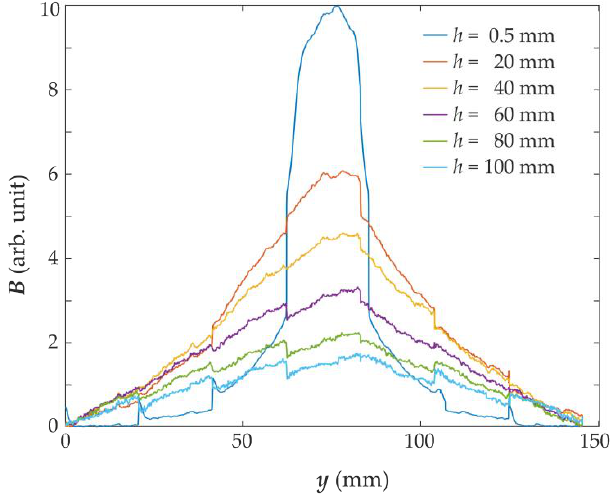
Figure 14. Impact of concrete cover thickness on the MO-sensor measurements. The average line profile of the magnetic field was measured using MO-sensor with the same pole magnetization SPM by moving the sensor along the y -axis.